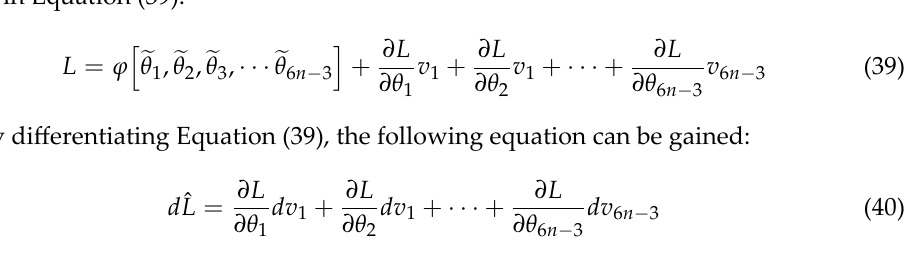
Figure 9. ( a ) The topographic map of the experimental water area; the red box indicates the area where the unit network is located (Reprinted with permission from Ref. [27]. 2022, John Wiley and Sons). ( b ) The structure of the unit network and trajectories of circle-sailing positioning.